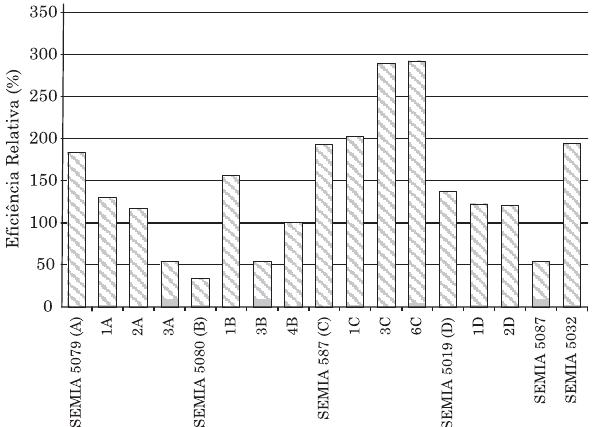
Figura 1. Índices de eficiência relativa dos tratamentos inoculados com estirpes e variantes de B. japonicum e B. elkanii em relação à produção de matéria seca de soja cultivar Clark, 35 dias após o plantio.